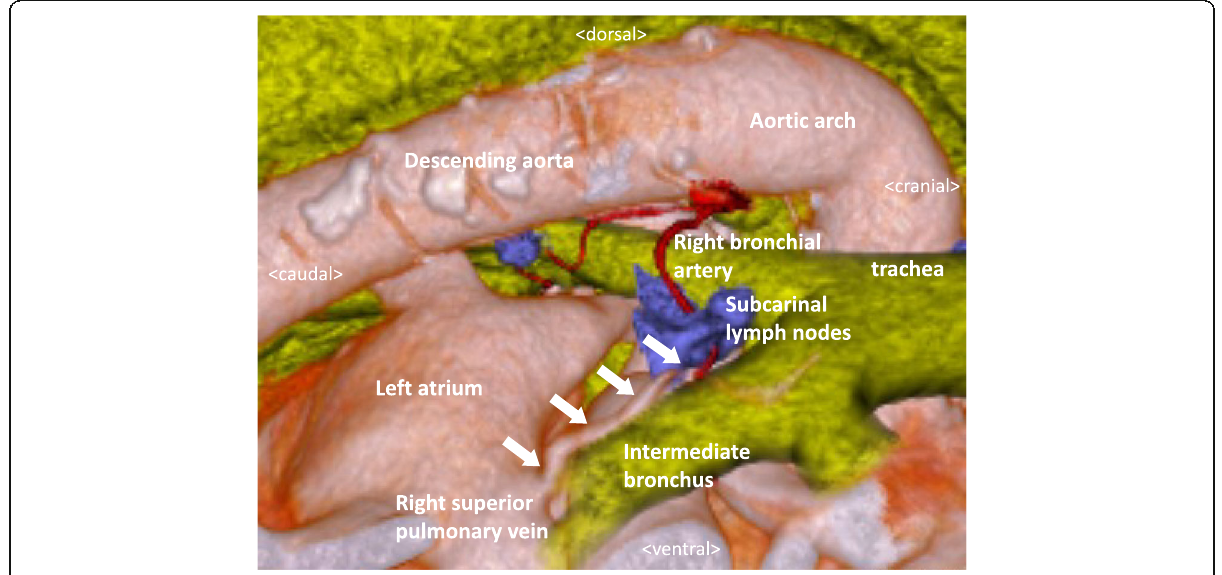
Fig. 3 Virtual thoracoscopic image. The anomalous V2 runs behind the intermediate bronchus (white